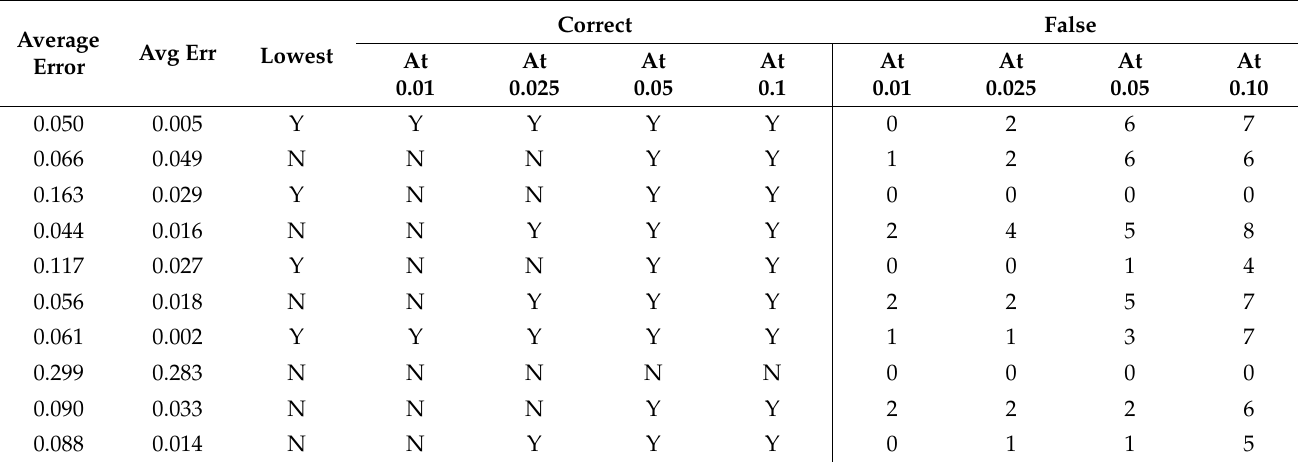
Table A154. Set 2, trials 41–50 summary data (actual PR value).